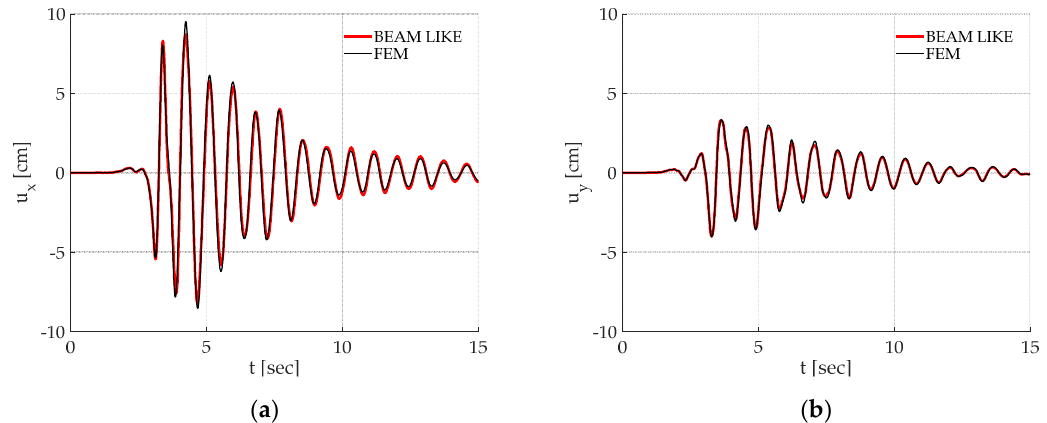
Figure 18. Six-storey benchmark. Santa Venerina earthquake. Displacements time history along the ( a ) x and ( b ) y direction.